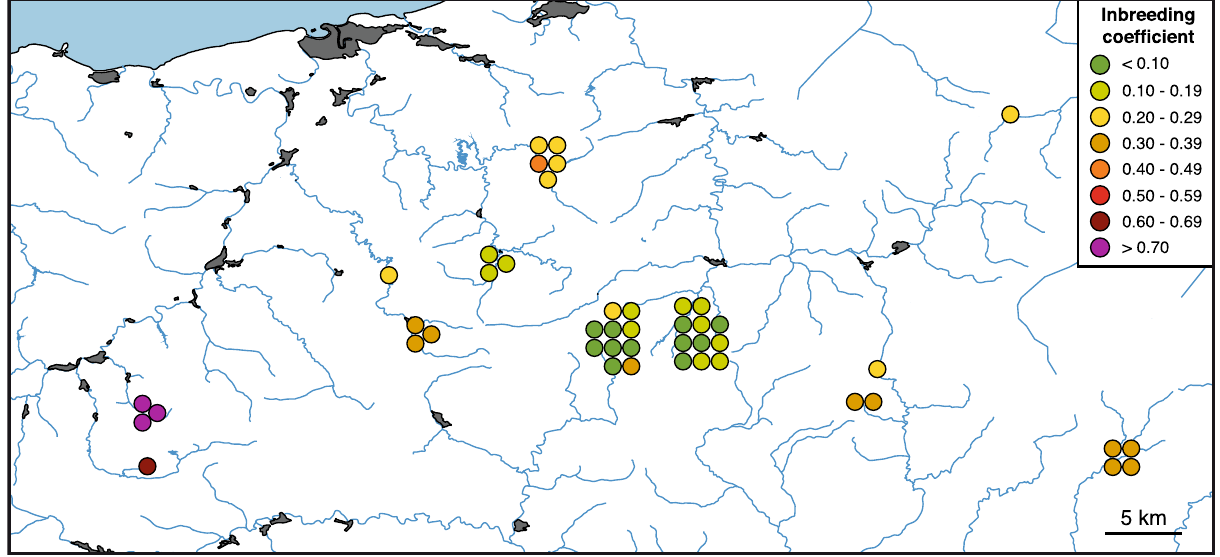
Figure 3. Map of the Iberian desmans with their inbreeding coefficients, estimated with RELATED, represented using a color scale. The map was constructed as indicated in the legend to Fig.